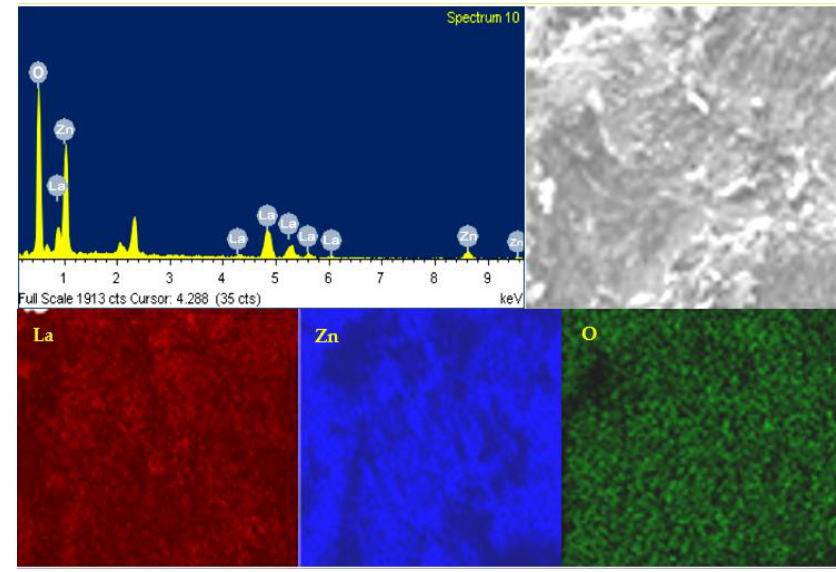
Figure 3. EDS spectrum and mapping for the La 2 ZnO 4 nanocomposite.